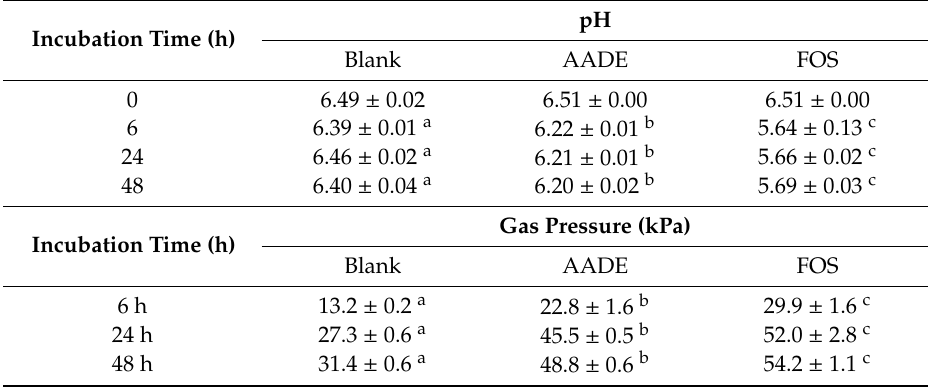
Table 3. Mean ( ± standard deviation) pH and gas pressure after 0, 6, 24, and 48 h of treatment of a simulated colonic microbiota with 5 g / L AADE (artichoke aqueous dry extract) or FOS (fructo-oligosaccharides). For each time point (0, 6, 24, or 48 h), a value indicated with a di ff erent letter (a, b, or c) indicates a statistical di ff erence between AADE, FOS, and / or the blank as tested with a two-way ANOVA with post-hoc Tukey test ( p <